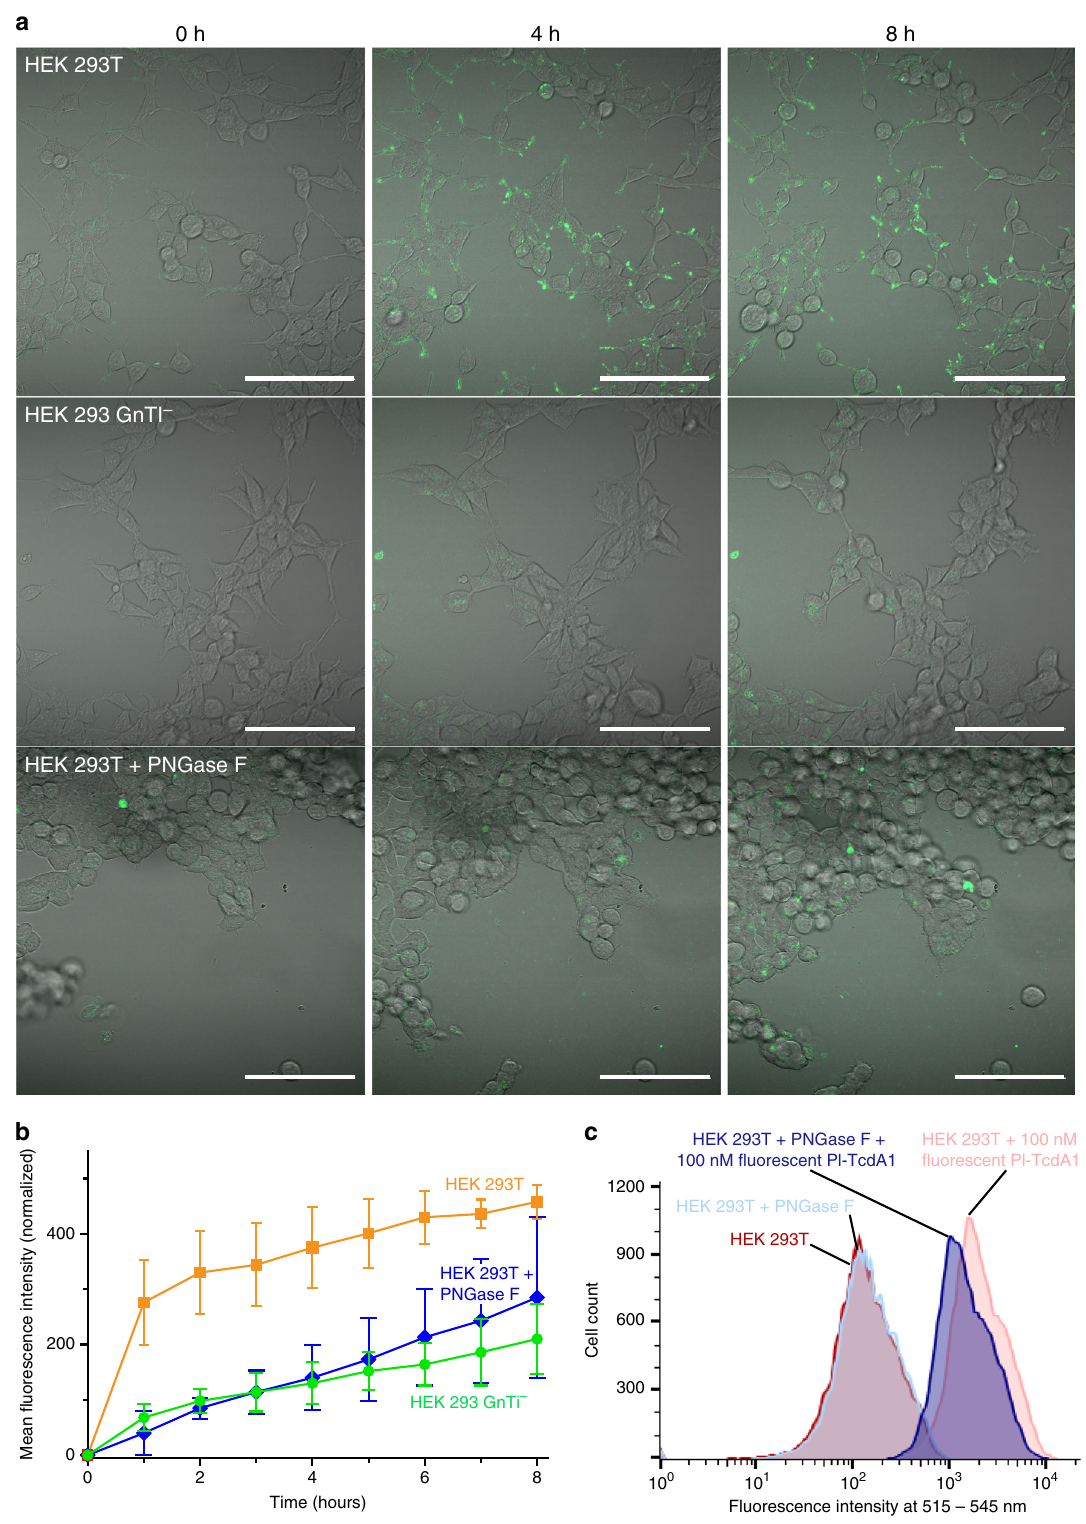
Fig. 1 The presence of complex glycans on target cells enhances the binding of Pl-TcdA1. a Time course confocal imaging demonstrates that wild type HEK 293T cells bind Pl-TcdA1 (AlexaFluor488 labeled, green) much more readily than their glycosylation-de fi cient HEK 293 GnTI − counterparts and PNGase F-treated HEK 293T cells. Images were taken after 0, 4, or 8 h of incubation at 37 °C. Scale bar, 100 μ m; fl uorescence channels are equally thresholded. b Quanti fi cation of AlexaFluor488 labeled Pl-TcdA1 binding to wild type HEK 293T (orange squares), PNGase F-treated HEK 293T (blue diamonds), and HEK 293 GnTI − cells (green circles) based on time course confocal microscopy data. Three biological replicates for each cell type were analyzed; error bars represent standard deviation. c Flow cytometry of HEK 293T exposed to AlexaFluor488 labeled Pl-TcdA1 after deglycosylation of cell surface by PNGase F. Histograms of PNGase F-treated and untreated cells, both with and without 100 nM Pl-TcdA1 are shown in comparison. The source data underlying panels ( b ) and ( c ) are provided as a Source Data fi